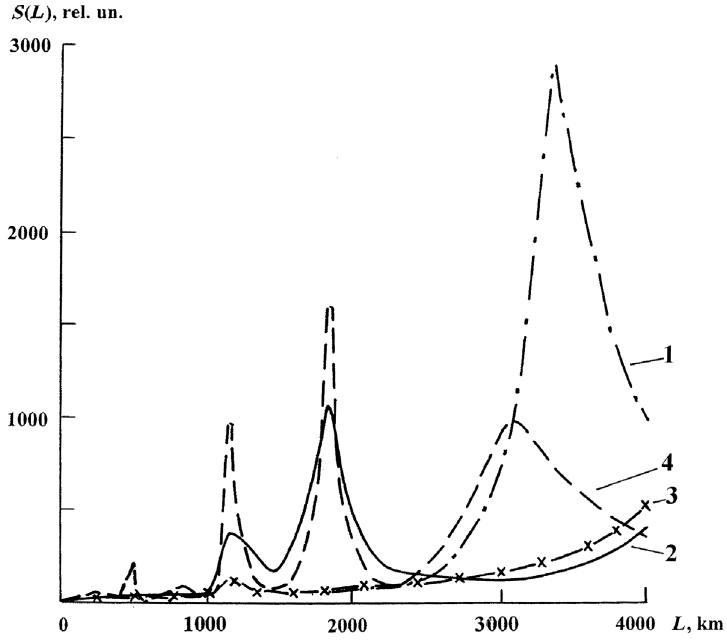
Fig. 2. Results of the spectral analysis of MEM of the magnetic field along satellite passes over the Pacific Ocean area. Periods (in km) are plotted as abscissa, spectrum densities (in relative units) – as